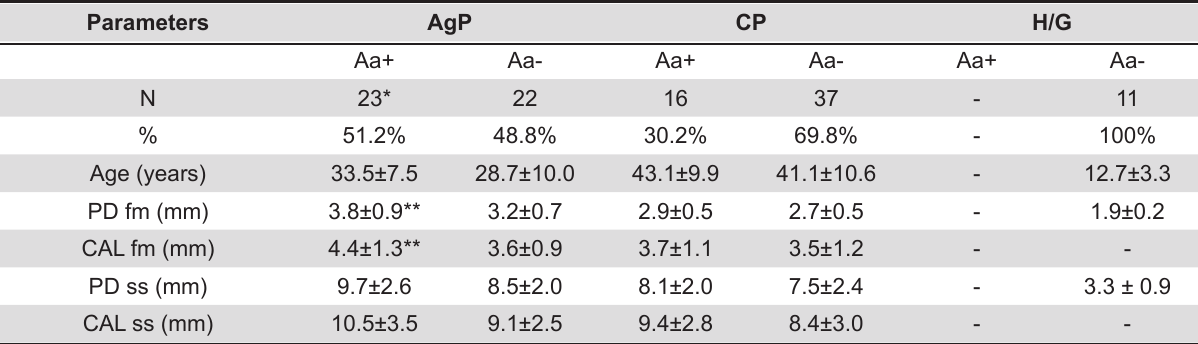
Table 2- Clinical periodontal parameters (mean± standard deviation) and the presence of A. actinomycetemcomitans in